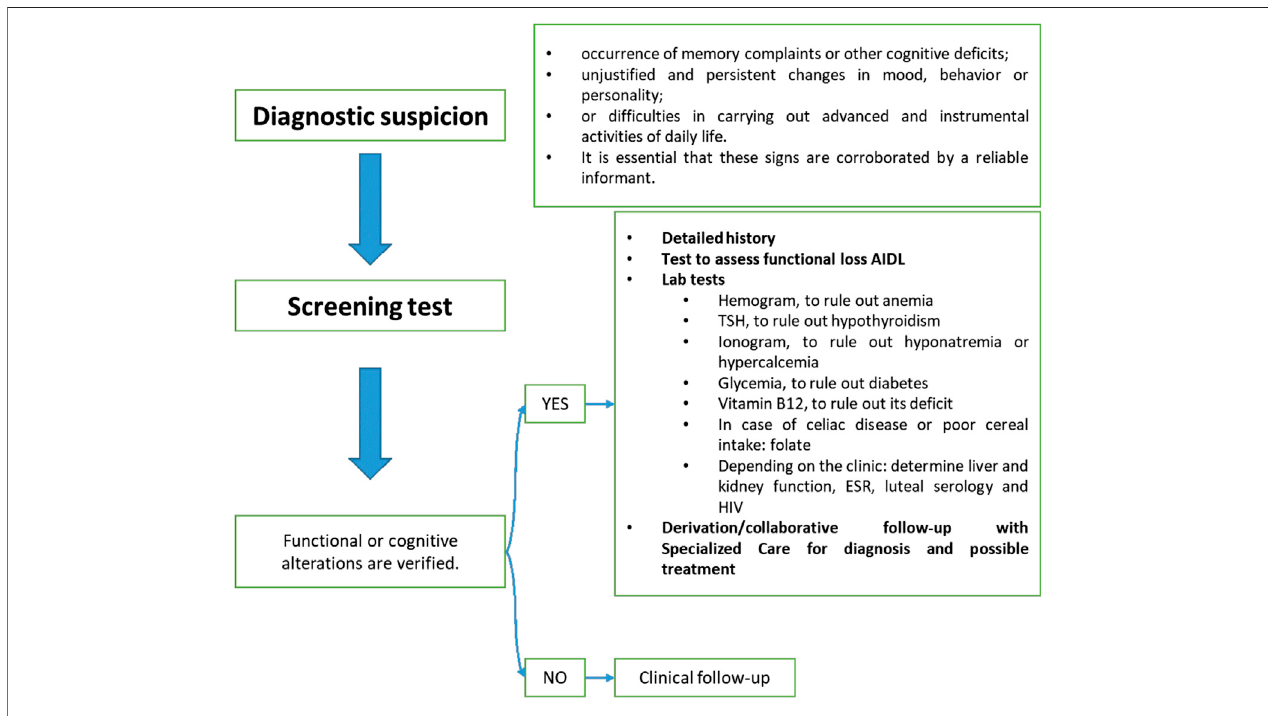
FIGURE 2 | Protocol of action in primary